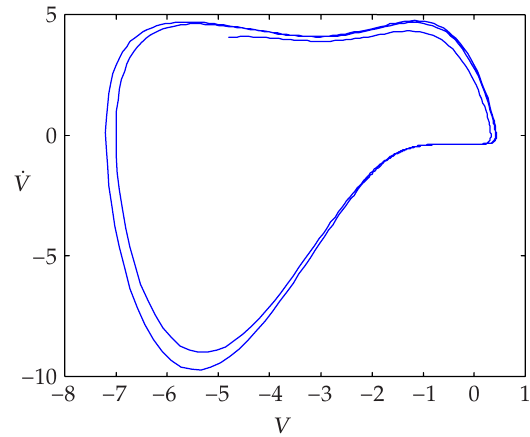
Figure 2.3 . Phase plot of the action potential V and its time- derivative ˙ V in the interval t ∈ ( 10 , 30 ) .